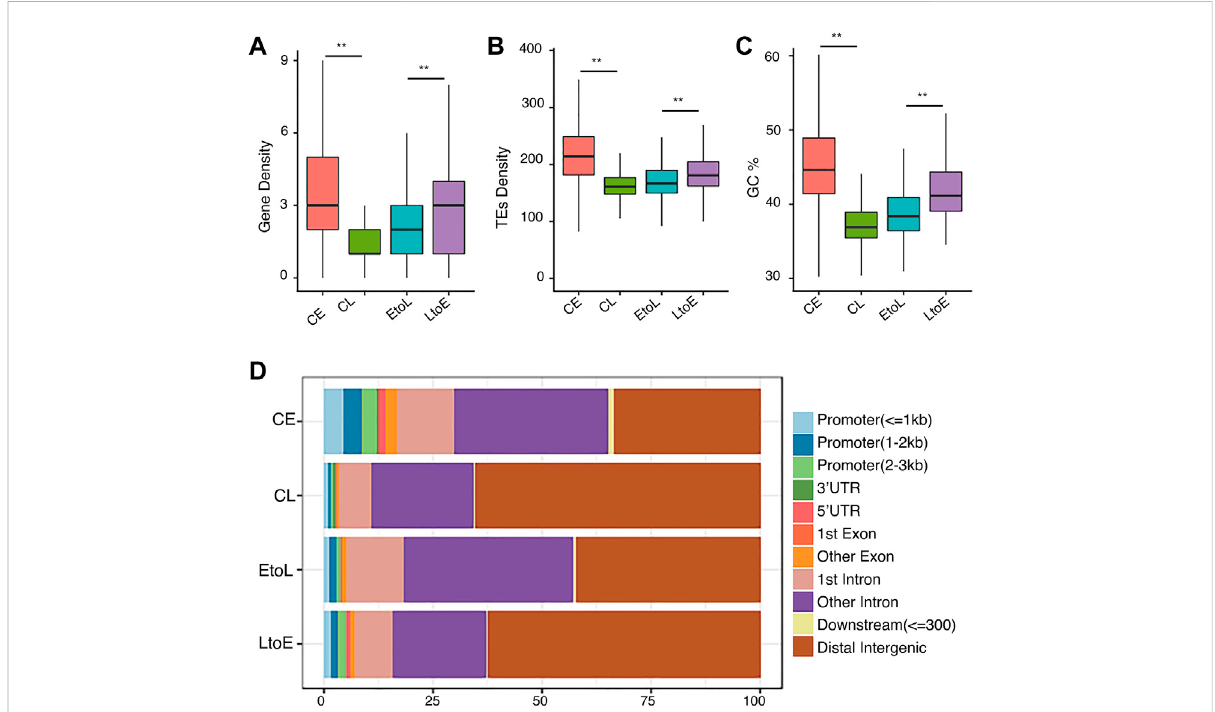
FIGURE 1 Genomicfeaturesofthefourreplicationtimingcategories. (A) Genedensitydistributionsofthefourreplicationdomains:constitutiveearly(CE), constitutive late (CL), early-to-late (EtoL), and late-to-early (EtoL). The unit is the number of genes per100 kb bin. (B) Density distributions of transposable elements (TEs). (C) GCcontentdistributions. (D) Region constitutions with respect to gene structure annotation. p values are